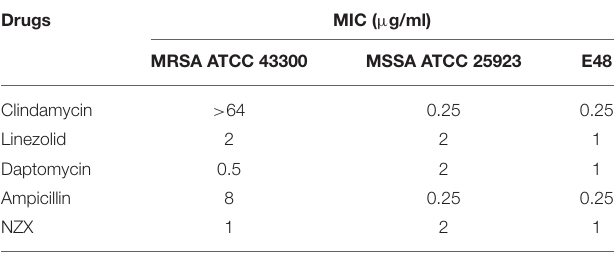
TABLE 2 | The MIC values of NZX and antibiotics against S. aureus